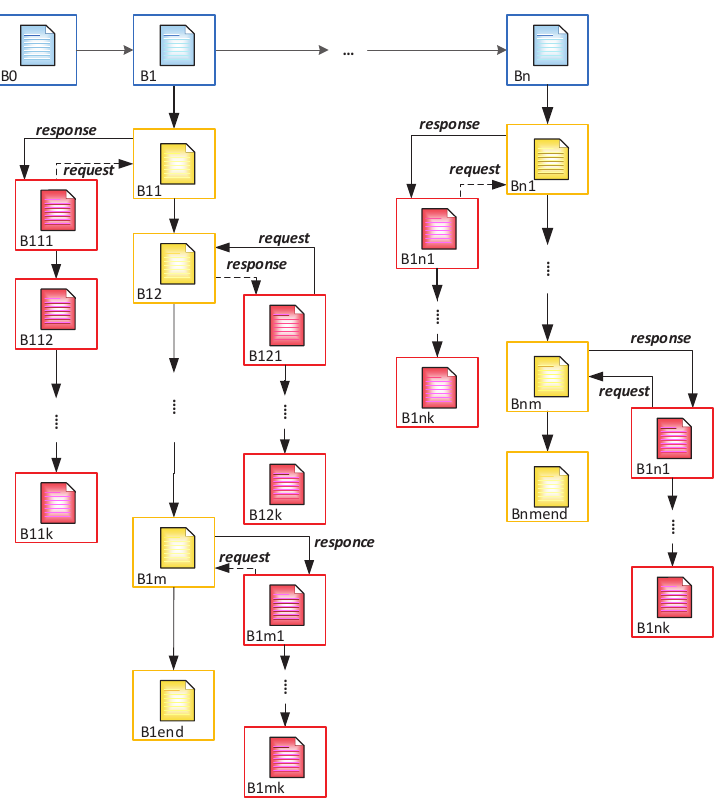
Figure 9. Blockchain Tree. There is a system of three Blockchains that are connected to each other. The blue BC is the main one and contains personal information about the ID-card holder; the yellow BC is a sub-BC and contains information about reissued ID-cards; the red chain is the second sub-BC and contains logs of customers, police, and other officers of special